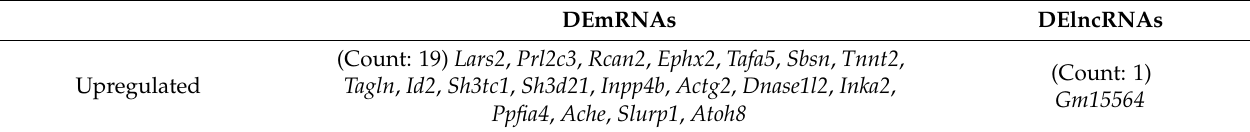
Table 1. The differentially expressed mRNAs and lncRNAs between two UV irradiated 661W cells with or without LSKL